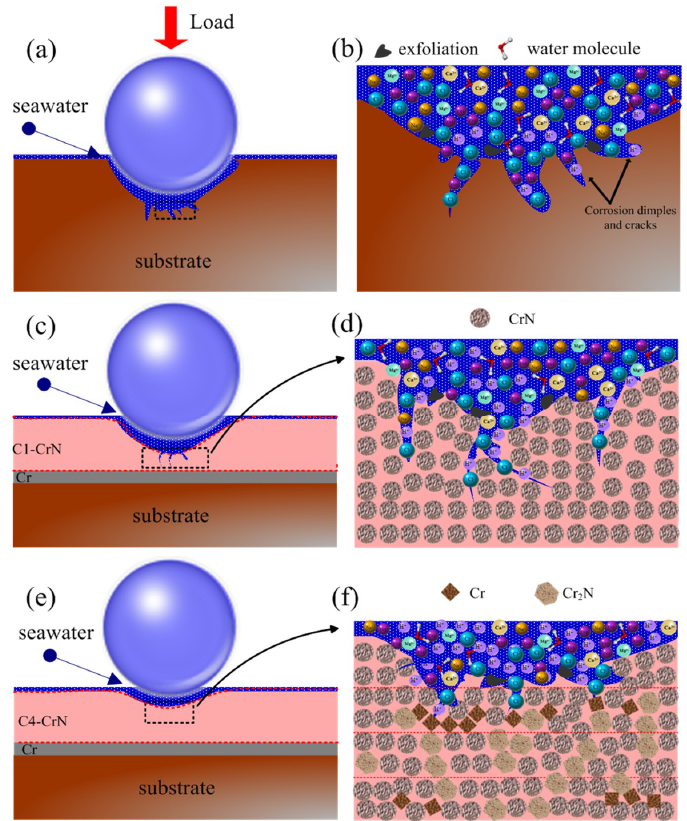
Figure 11. The detailed schematic diagrams of 316L substrate ( a , b ), C1 ( c , d ) and C4 ( e , f ) films in seawater.